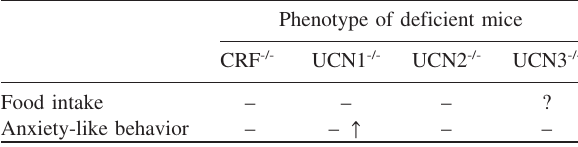
Table 1 Effects of CRF family peptide deficiencies on feeding and anxiety-like behaviors in knockout mice.